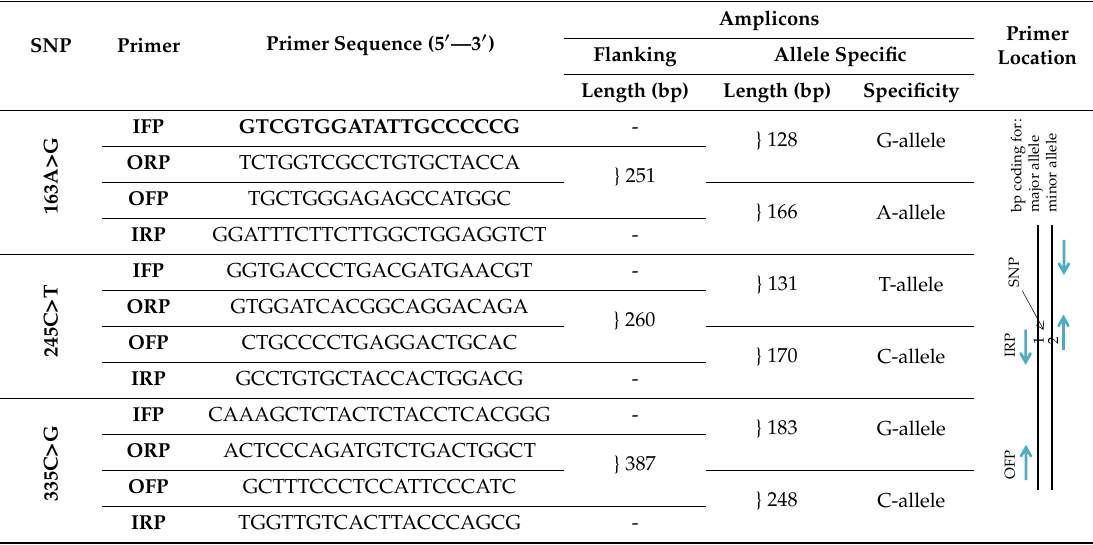
Table 2. Primer sequences used to detect SNPs of the PADI4 gene and resulting amplicon lengths. SNP Primer Primer Sequence (5 ′ —3 ′ )